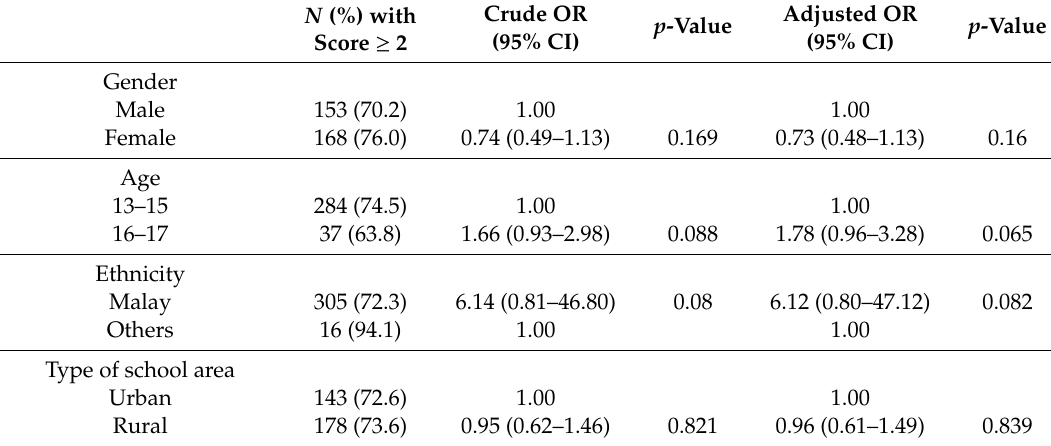
Table 6. Bivariable and multivariable logistic regression predicting practice on SSB among participants, ( N =